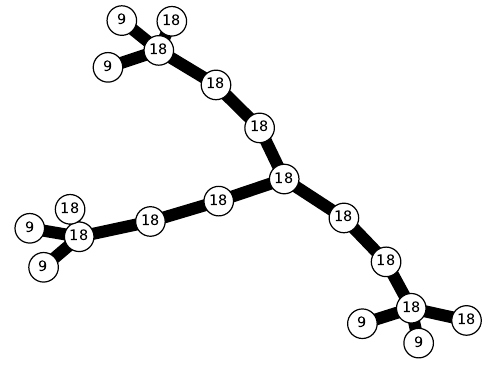
Figure 9: Example of a Kempe sector with ( I a , I , I ± ) = ( 1, − 1,1 ) for L = 18, repre- 2 2 sented as a graph: nodes (winding number configurations ( a , b , c ) , up to permu- tations) are connected by the dynamics. Indicated is the minimal size L for the configuration to fulfill the constraints, thus showing that the paths between L = 9 configurations are cut, giving 1 → 6 isolated sectors by steric